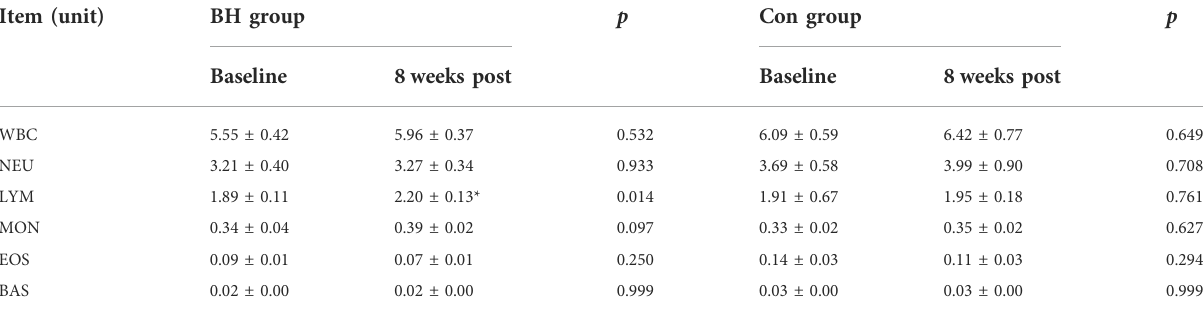
TABLE 4 Variations of immune cell